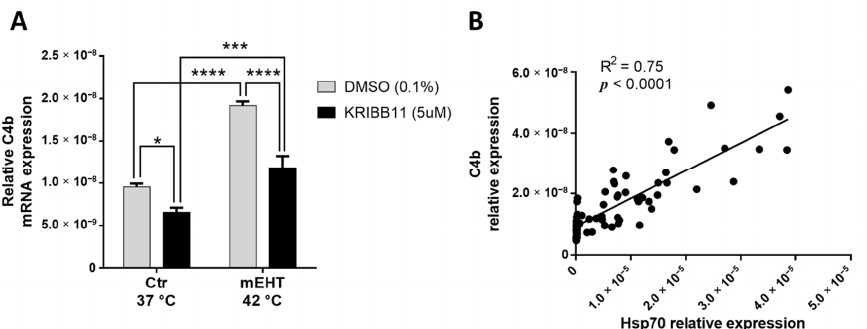
Figure 7. KRIBB11 effect on mEHT-induced C4b production. C4b mRNA relative expression, 2 h post-mEHT, normalized to 18S, with KRIBB11 treatment, vs. DMSO ( A ). Correlation between C4b and Hsp70 expression ( B ). Mean ± SEM,